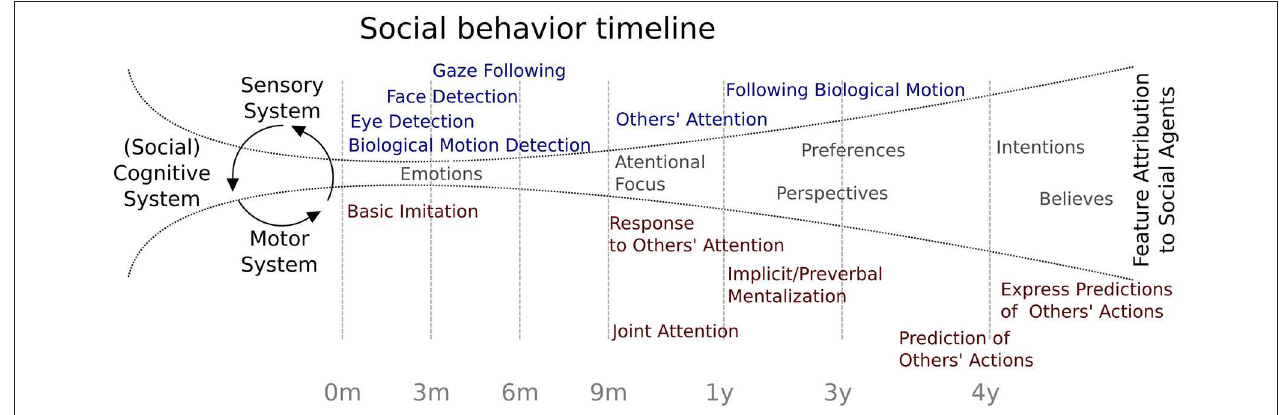
FIGURE 1 | Social behavior timeline. Chronology of major social behavior milestones during childhood. Blue indicates evidence related to sensory system maturation and red indicates findings related to motor system maturation. In gray are represented possible feature attributions to social agents.